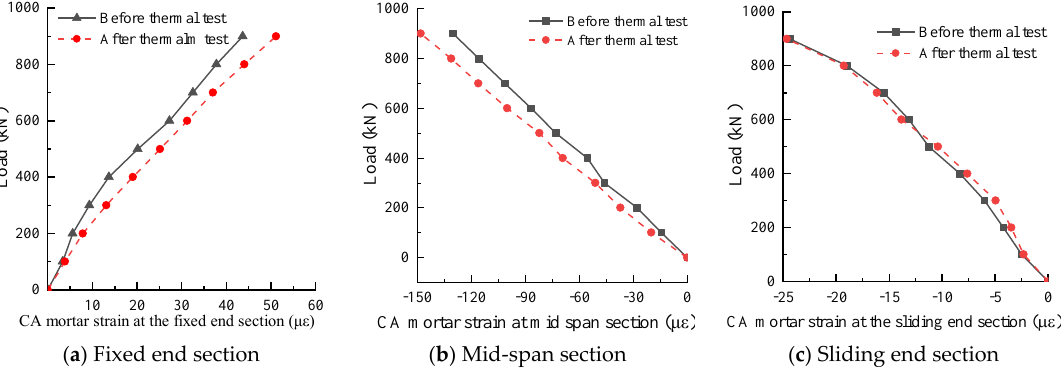
Figure 21. Load–strain curve of the CA mortar under static load.